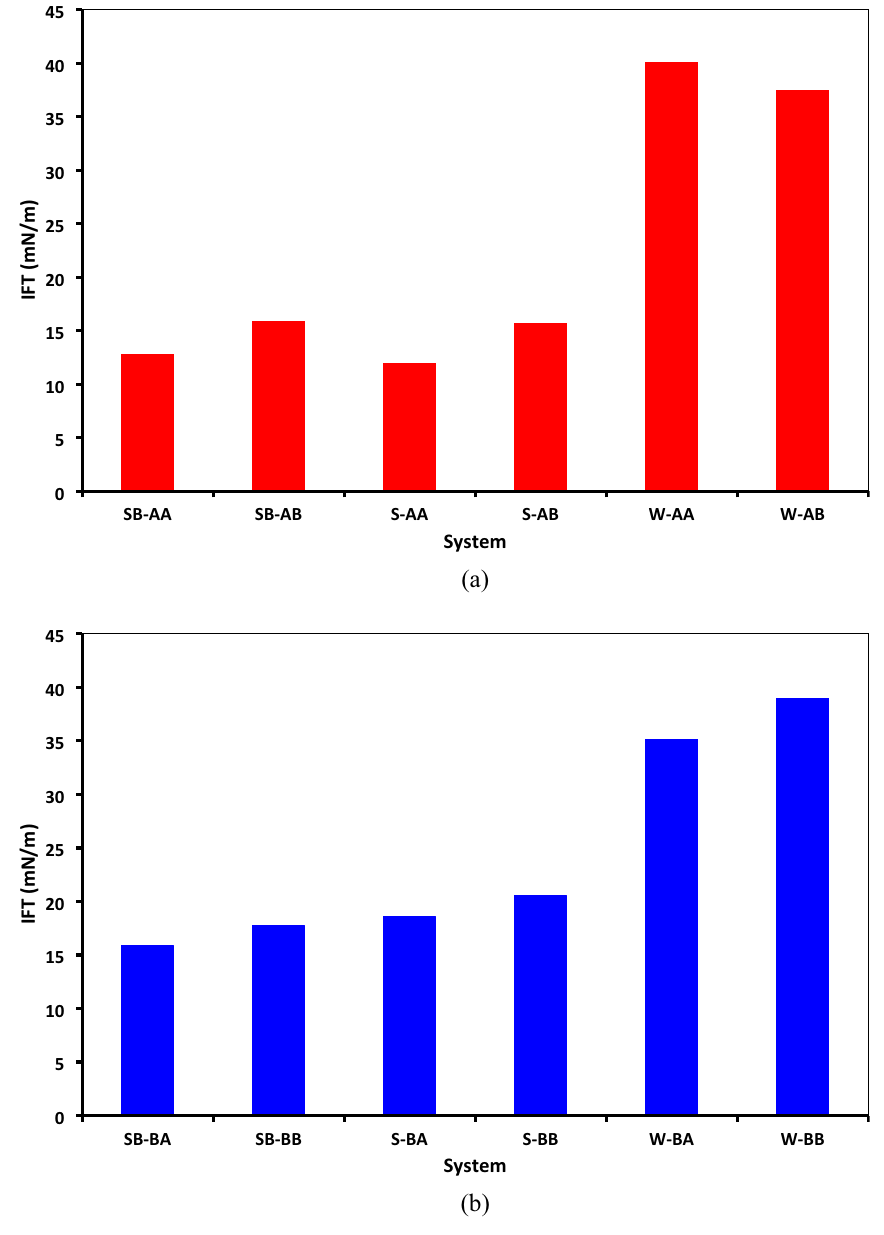
Figure 20. Comparison between IFT values for systems containing ( a ) C 40 H 30 O 2 , ( b ) C 44 H 40 N 2